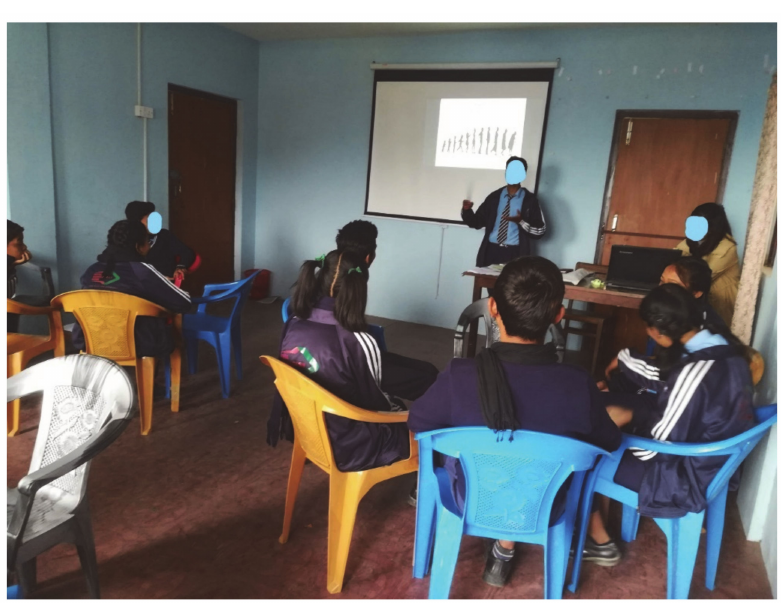
Figure A1. The education program in intervention